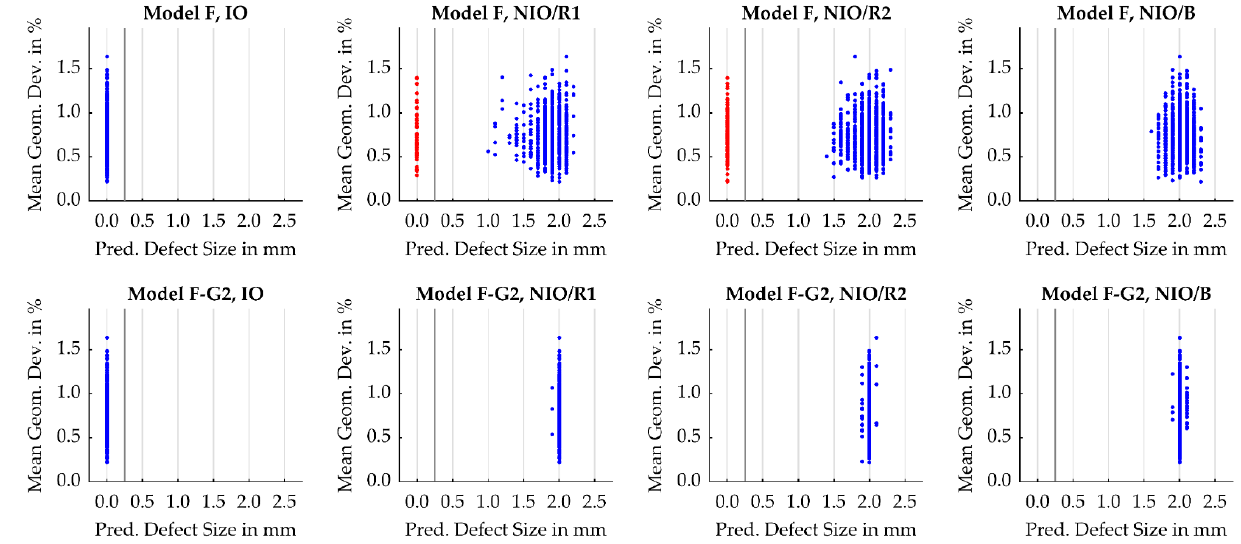
Figure 11. Classification results for 1000 virtual connecting rods each being either undamaged (IO) or featuring a 2 mm through-hole anywhere in the smaller cylinder ring (NIO/R1), the larger cylinder ring (NIO/R2), or the bar area (NIO/B), based on the classification models F and F-G2 both derived from training data without additional noise (blue: classified correctly, red: misclassified).